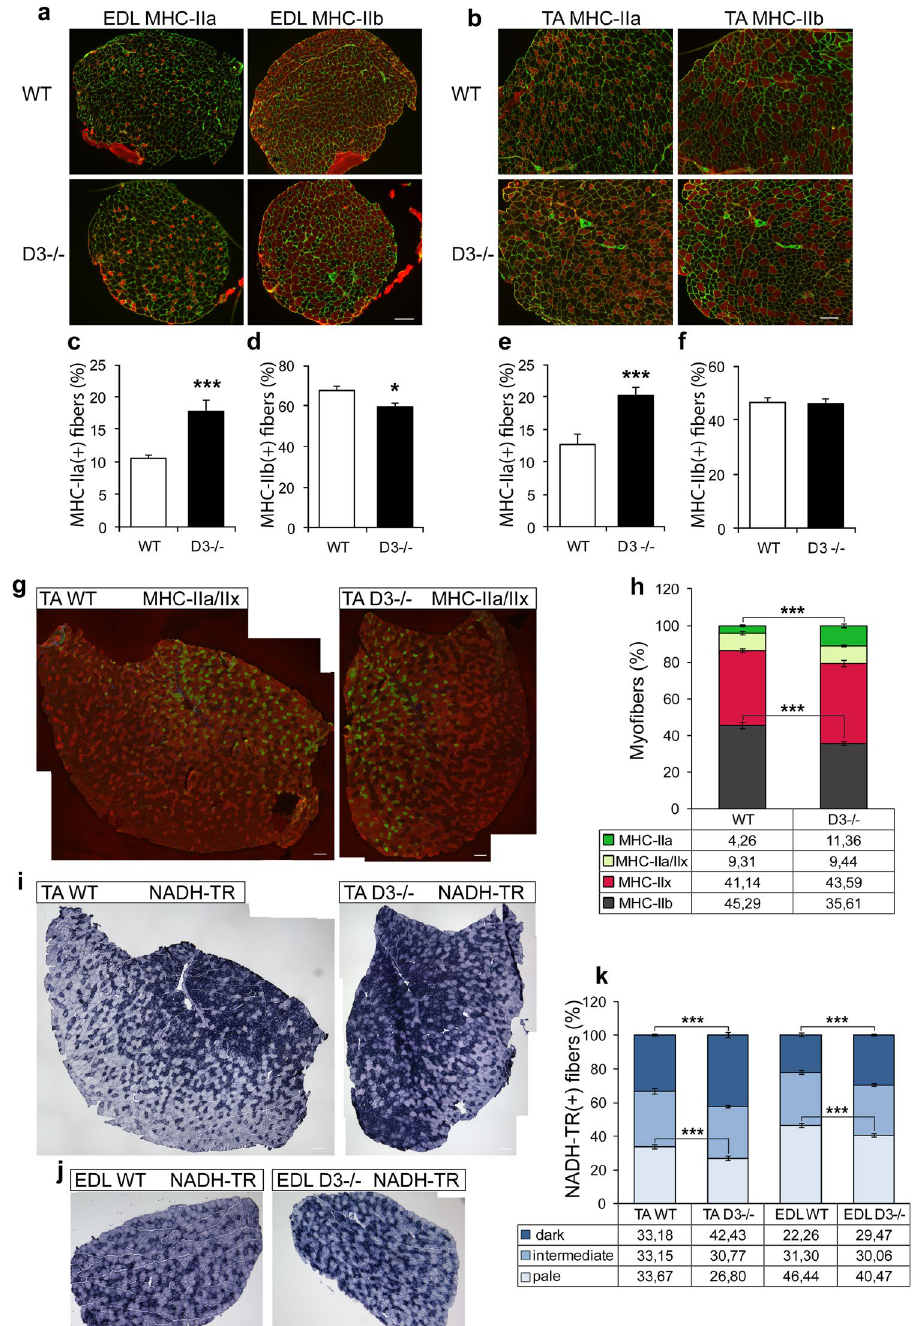
Figure 5. Cyclin D3 regulates muscle fiber type. ( a , b ) Immunoistochemical analysis of MHC isoforms in EDL and TA muscles of adult D3 − / − and WT mice. Tranverse serial sections of EDL (panel a) or TA muscles (panel b) co- immunostained for laminin (green) to visualize myofiber profiles and either MHC-IIa or MHC-IIb (red). Shown are entire EDL sections and fields of the TA red region. ( c – f ) Quantification of MHC-IIa and MHC-IIb fibers in EDL (panels c,d) and TA (panels e,f) serial sections (EDL: WT, n = 4; D3 − / − , n = 4; TA: WT, n = 4; D3 − / − , n = 5). ( g ) Transverse sections of WT and D3 − / − TA muscles co-immunostained for MHC-IIa (green) and MHC-IIx (red) and couterstained with DAPI. ( h ) Quantification of MHC-IIa, MHC-IIx, MHC-IIa/IIx and MHC- IIb (unstained) fibers in WT and D3 − / − TA sections (WT, n = 4; D3 − / − , n = 4). ( i , j ) Histochemical staining of NADH-TR enzymatic activity in transverse sections of WT and D3 − / − TA (panel i) and EDL (panel j) muscles. ( k ) Quantification of the number of differentially stained NADH-TR-positive fibers in WT and D3 − / − TA and EDL muscle sections (WT, n = 4; D3 − / − , n = 4). The data in graphs shown in panels (c–f,h,k), are expressed as the percentage in each category of the total number of fibers per section and are presented as means ± SEM. Quantification was carried out in least three sections per individual mouse. Statistical differences between WT and D3 − / − mice were assessed by two-tailed unpaired t-tests ( *** p < 0.001, * p < 0.05). Scale bar: 100 μ